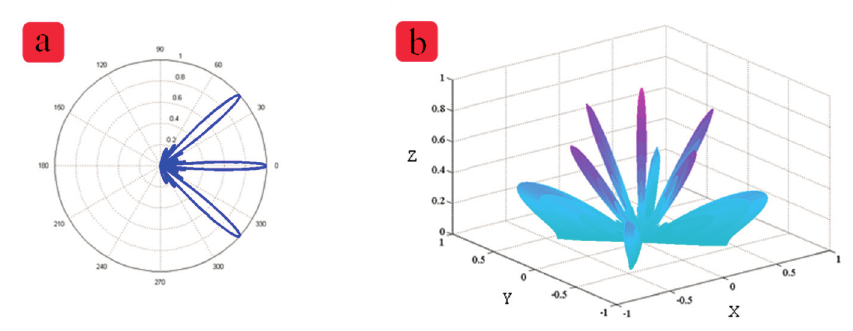
Figure 3. The directivity simulation results with the Matlab software. The distance between